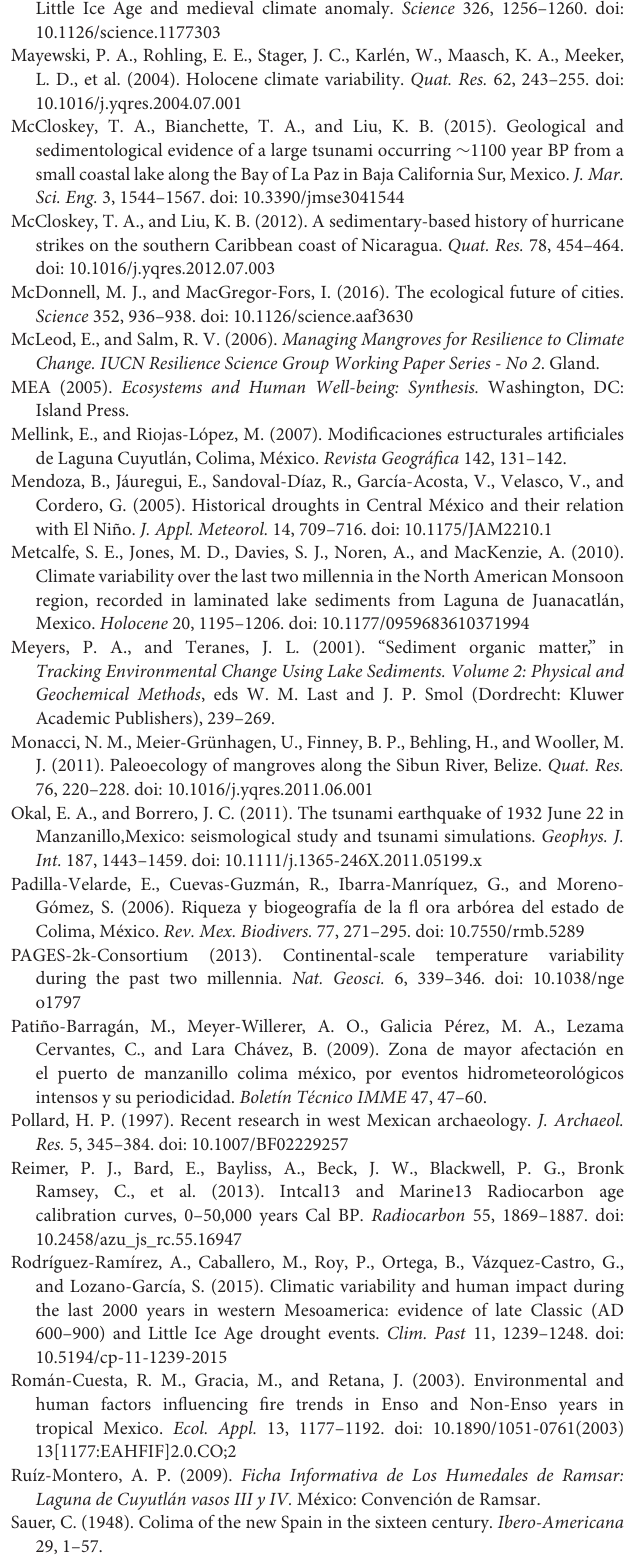
Figueroa-Rangel, B. L., Willis, K. J., and Olvera-Vargas, M. (2010). Cloud forest dynamics in the Mexican neotropics during the last 1300 years. Glob.